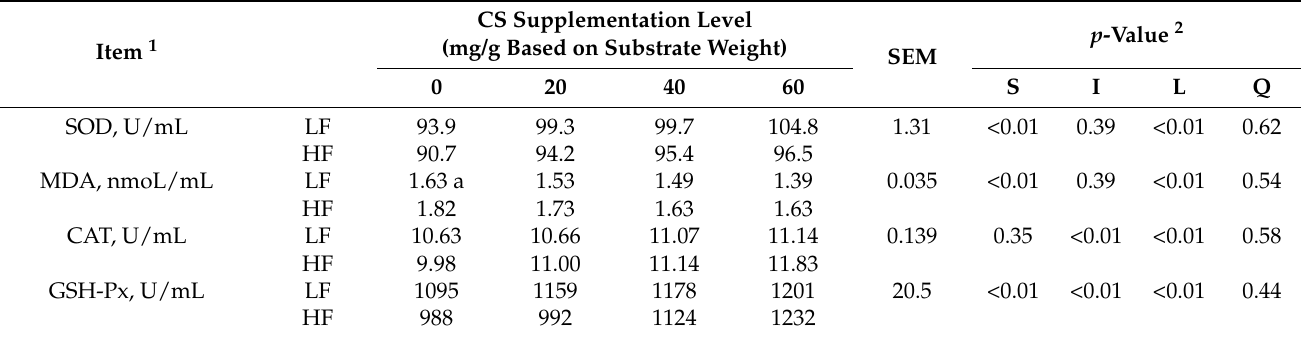
Table 4. Effects of substrates and increasing CS supplementation level on antioxidant capacity of fermentation